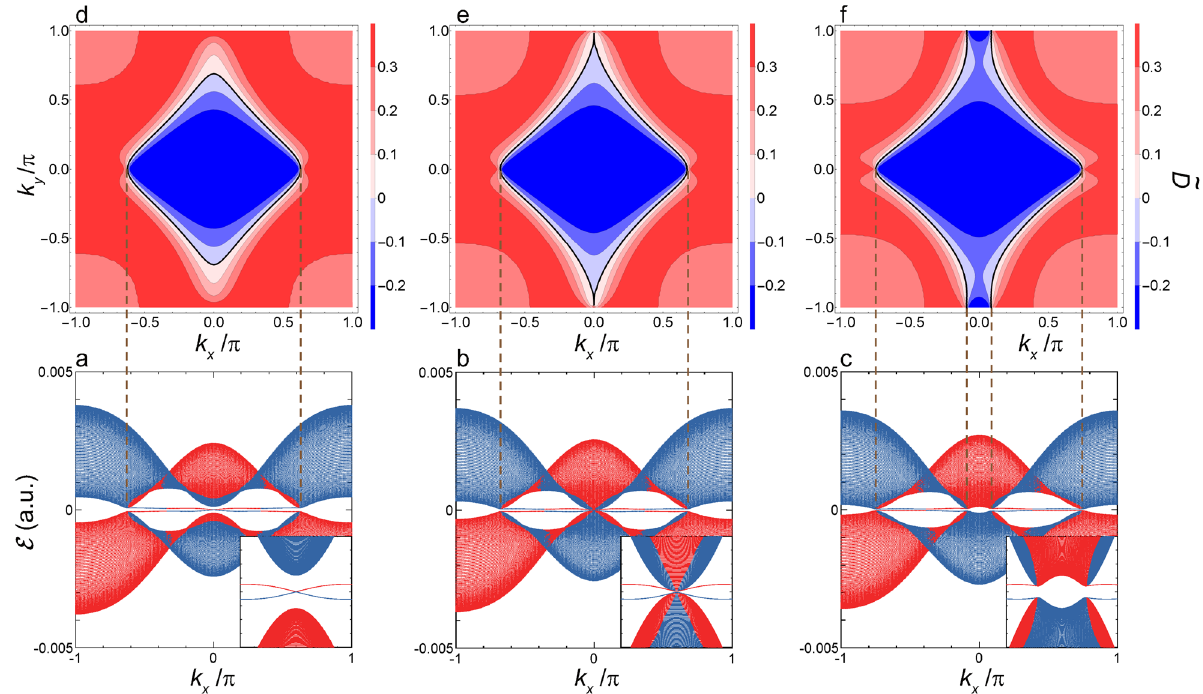
Figure 5. Quasienergy dispersion of E ( k x ) and interband polarization ˜ D ( k ) in the vicinity of F X 2 x . ( a ) Shown are E p ( 1 ) ( k x ) and E s ( − 1 ) ( k x ) as functions of k x at F x = 2.14 × 10 − 4 ( 1.10MV/cm ) ( F X 2 x < F x < F Ŵ x ) . The two quasienergy bands p (1) and s ( − 1 ) are shown by red and blue lines, respectively. Inset: the expanded view of these two bands in the vicinity of the ¯ X 2 -point. ( b ) The same as the ( a ) but at F X 2 x = 2.04 × 10 − 4 ( 1.05MV/cm ) . ( c ) The same as the ( a ) but at F x = 1.94 × 10 − 4 ( 997 kV/cm ) ( F X 1 x < F x < F X 2 x ) . ( d ) Shown is a contour map ˜ D ( k ) in the ( k , k x y ) -plane at F x given by ( a ). The vertical dashed lines show the projection of zero contour) onto the k x -axis shown in the ( a ). ( e ) The same as the ( d ) but at F X 2 x and with the zero contour projected onto the k x -axis shown in the ( b ). ( f ) The same as the ( d ) but at F x given by ( c ) and with the zero contour projected onto the k x -axis shown in the ( c